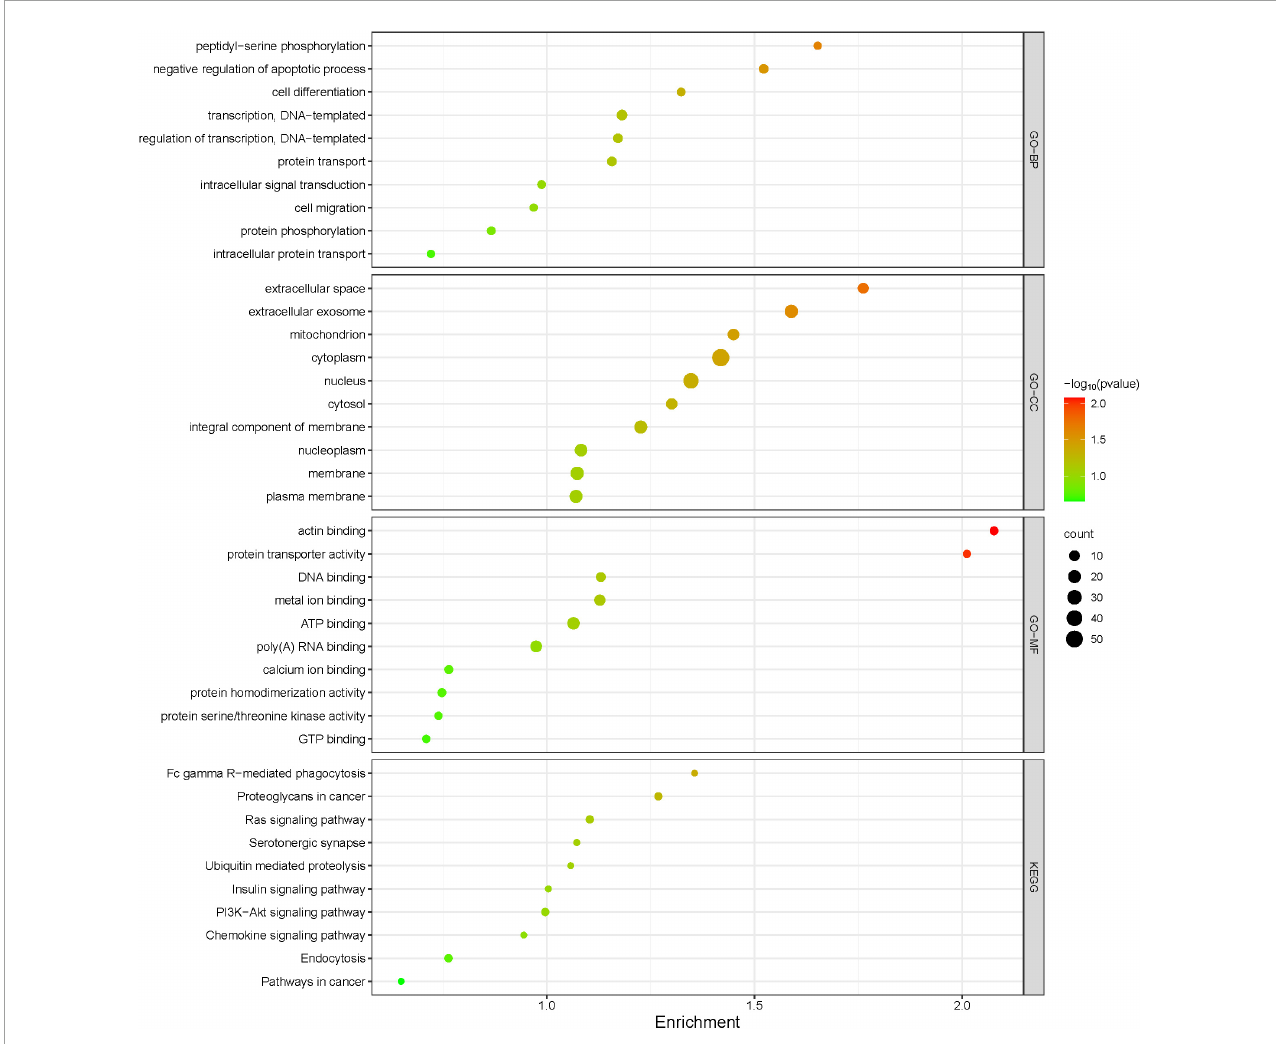
FIGURE4 Gene Ontology functional annotations and KEGG pathway analysis of ASE in treating PD. The radius of the circle indicates the number of genes enriched, while the color indicates the number of p